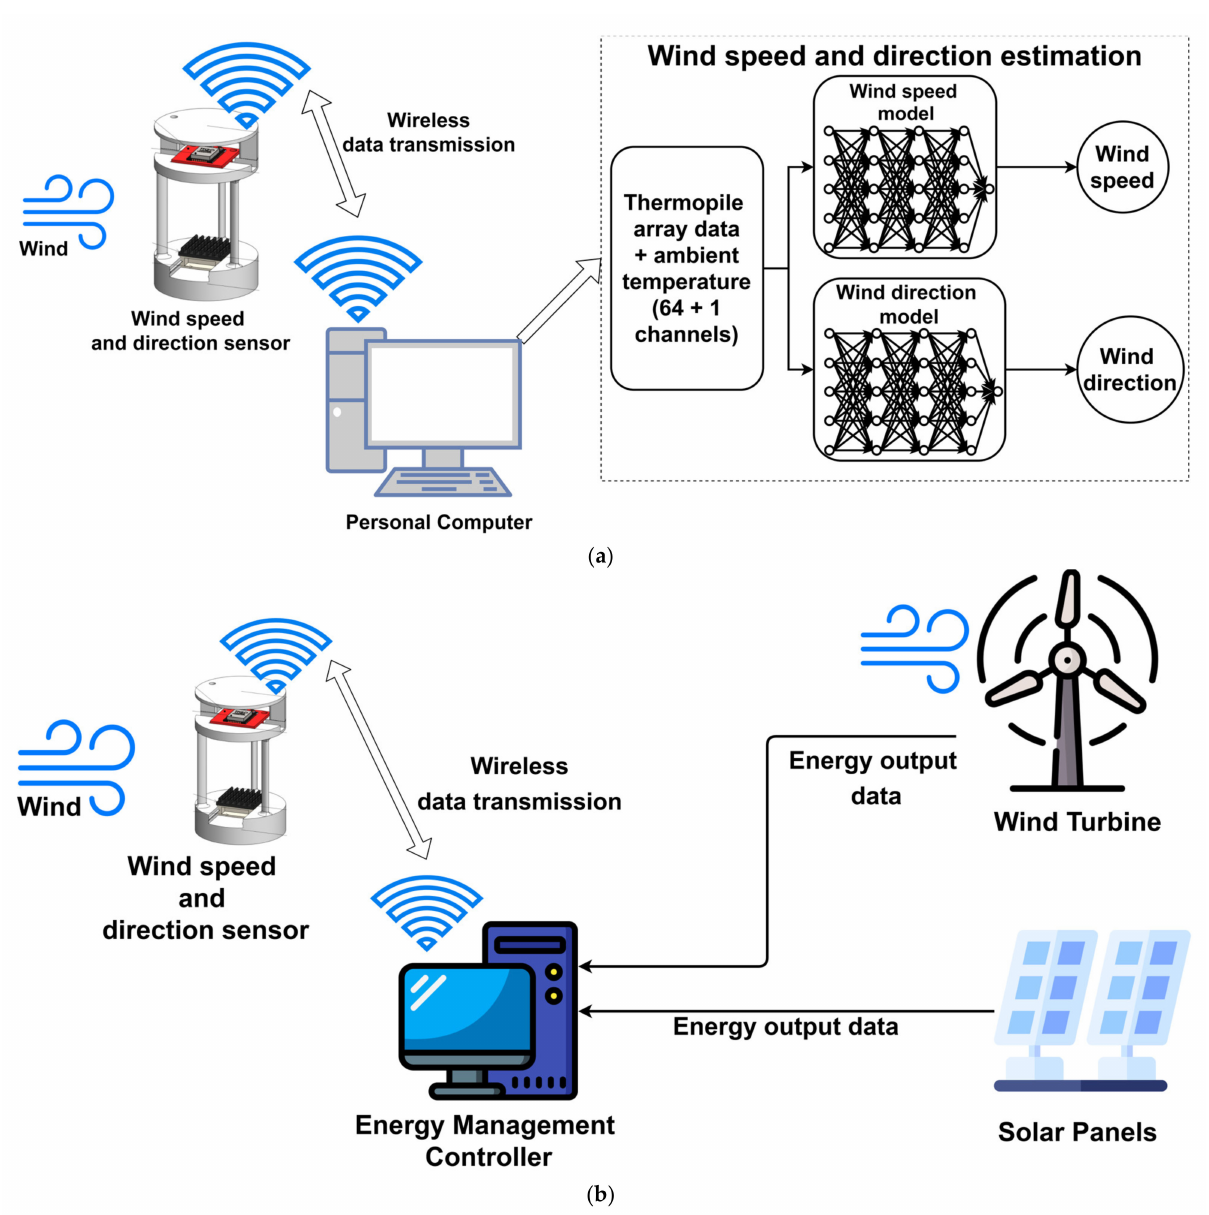
Figure 3. ( a ) Estimation and working principle proposed wind speed and direction sensing system using ANN models. ( b ) Potential application of the proposed